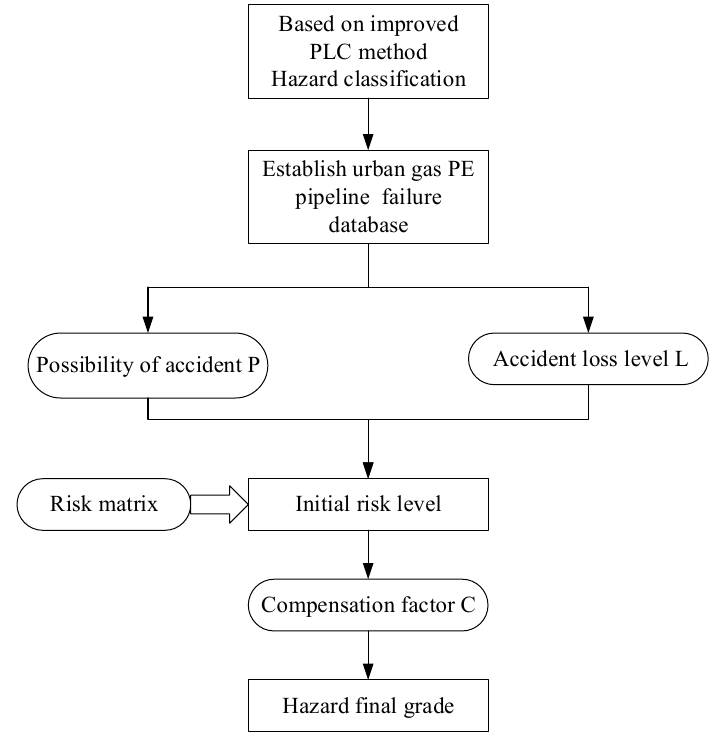
Figure 2. The process of hidden danger grading.